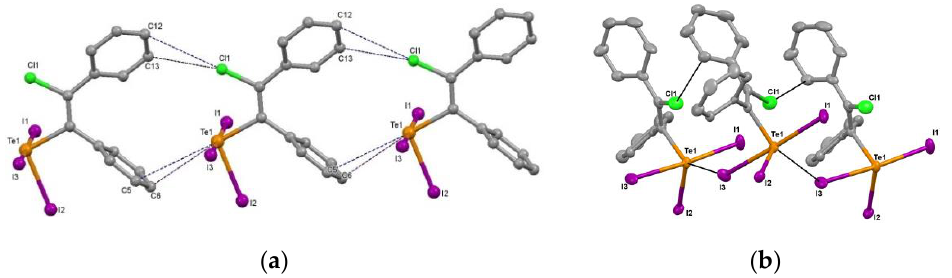
Figure 3. Packing pattern of Z -Cl(Ph)C=C(Ph)TeI 3 molecules in the polymorphic forms 2α ( a ) and 2β ( b ). Hydrogen atoms are omitted for clarity. Selected intramolecular distances in 2α (Ǻ): Te1